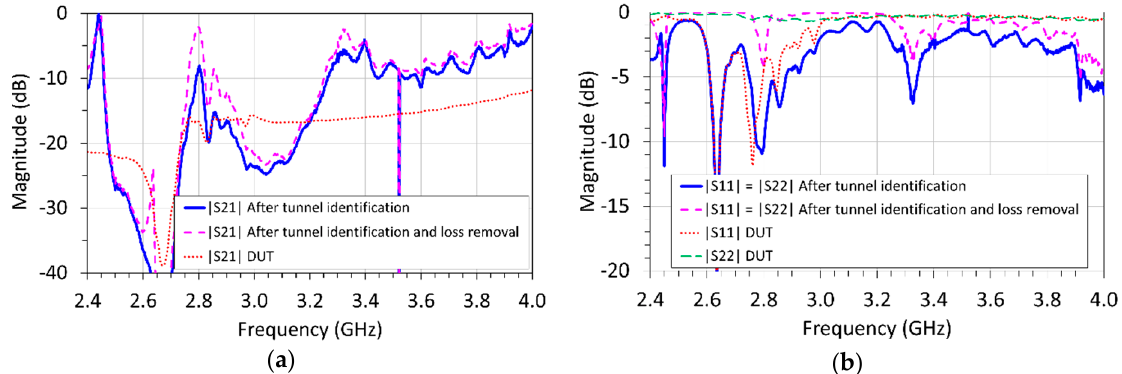
Figure 11. S-parameter magnitude frequency responses after tunnel identification and after loss is